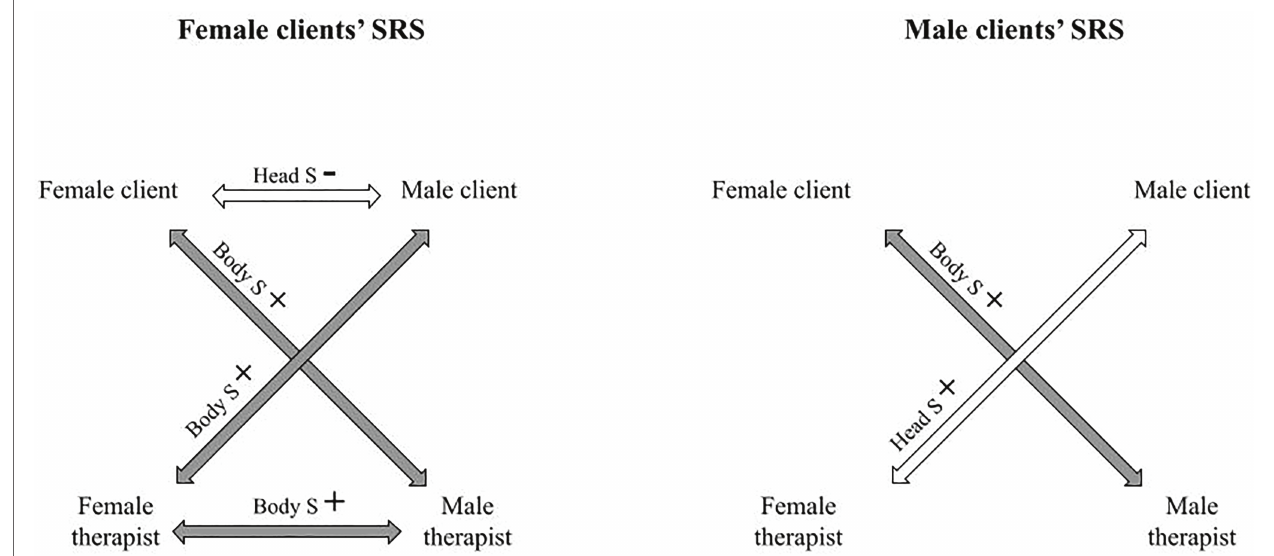
FIGURE 2 | The relationship between the clients’ alliance evaluations and the dyadic head and body synchronies.